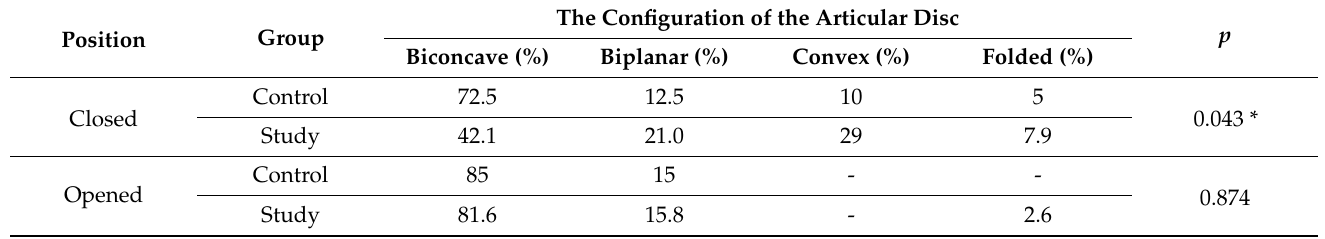
Table 3. The distribution of disc configuration between the study group and the control group.